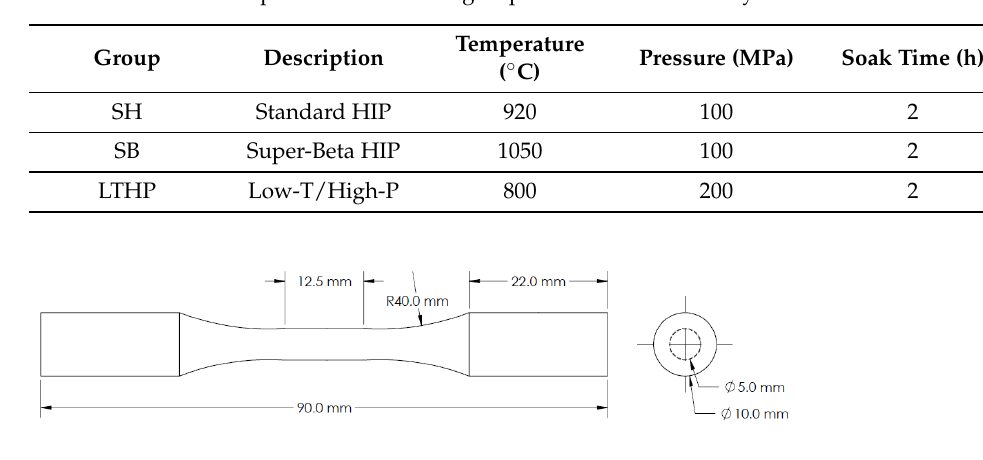
Figure 2. Fatigue specimen